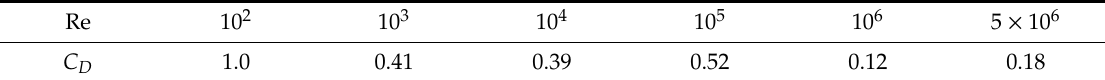
Table 1. Drag coe ffi cient of the floater.